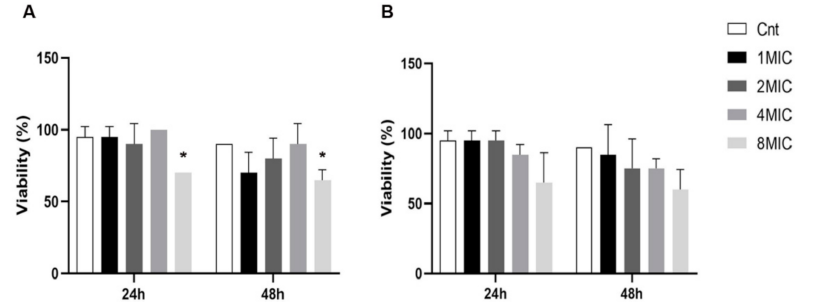
Figure 3. Toxicity of Cz and Ov EOs on G. mellonella larvae: ( A ). Plot refers to Cz toxicity; ( B ). Plot refers to Ov toxicity. Data are expressed as mean ± standard error of the mean. * p < 0.05 p -values were calculated relative to the